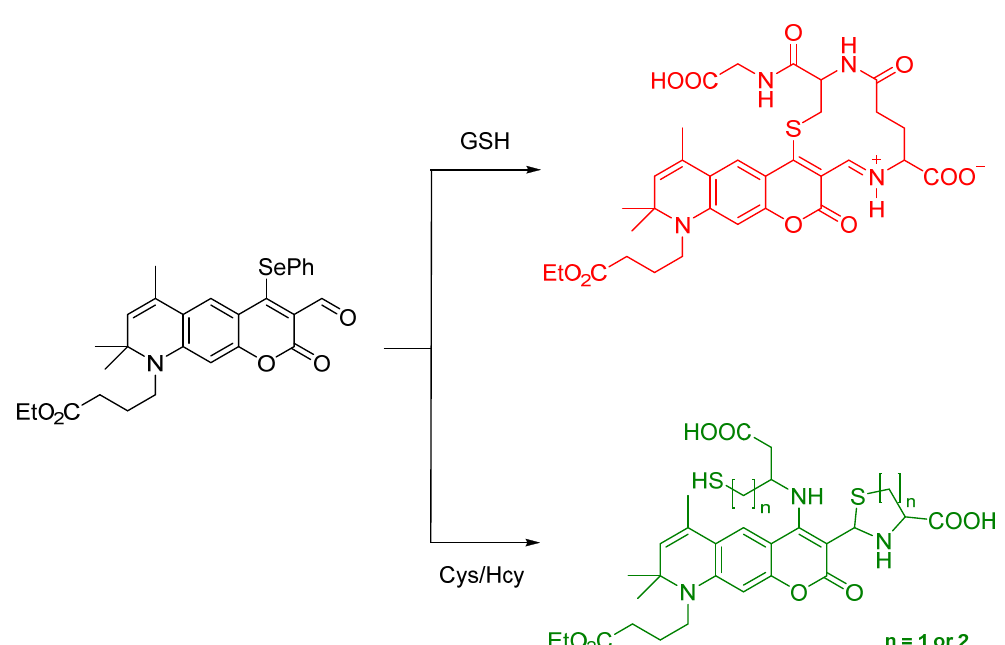
Figure 31. Selective detection of GSH using a coumarin in which the SePh group and CHO group are both serving as adjacent reactive groups.